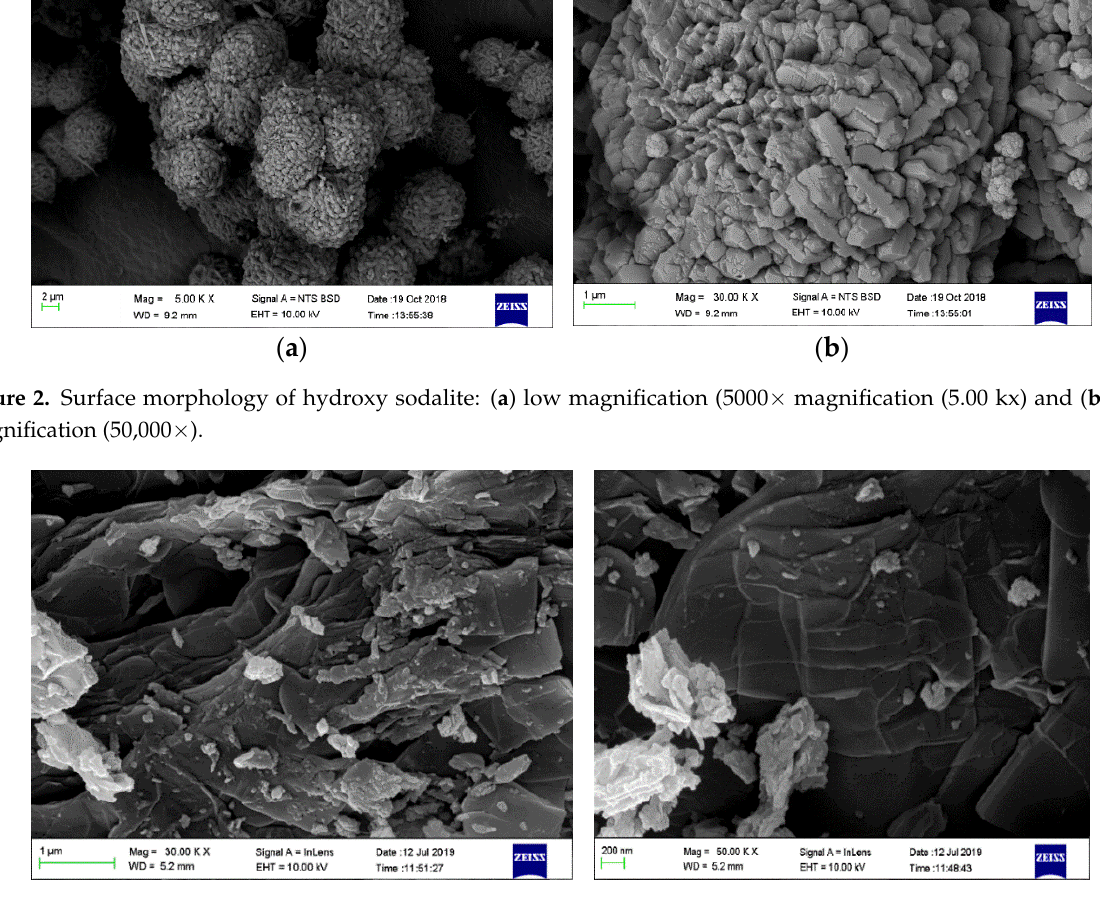
Figure 3. Surface morphology of silica sodalite: ( a ) low magnification (30.00 KX) and ( b ) high mag- nification (50.00 KX).